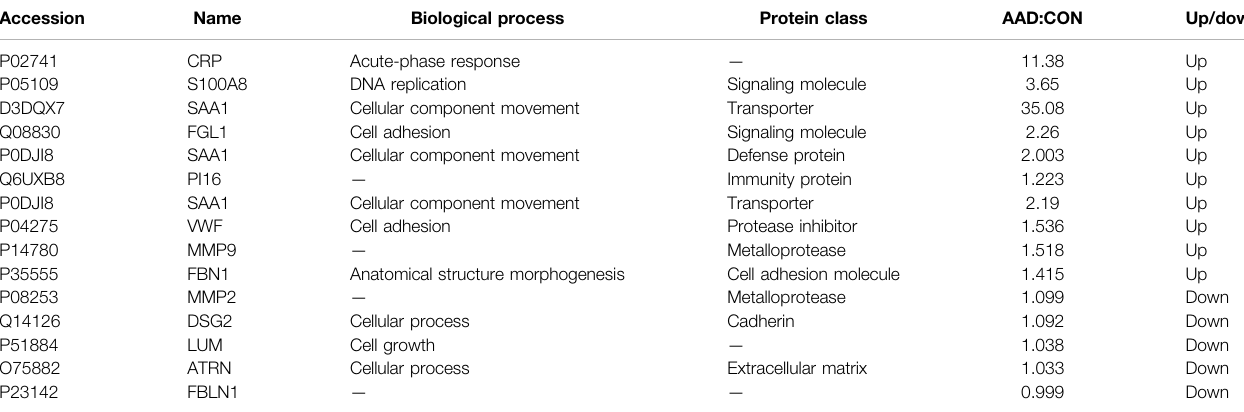
TABLE 5 | Subset of differentially expressed proteins between the AAD and control groups.